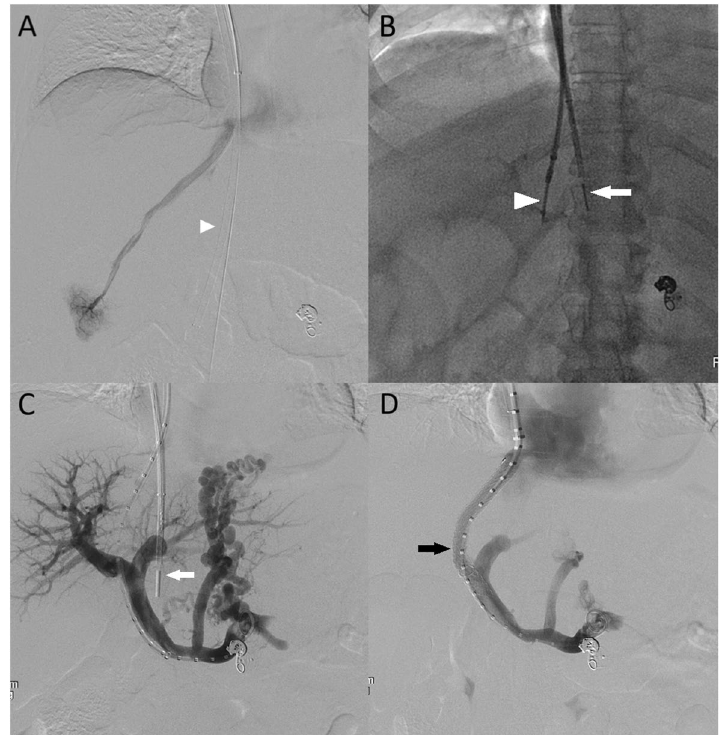
Fig. 2 A Sample Case of Splenoportogram and TIPS placement. A. Right hepatic vein venogram with Blakemore tube noted in the background (white arrowhead). B. ICE catheter (white arrow) positioned at the level of the main portal vein. Advancement of the needle (white arrowhead) through hepatic vein towards main portal vein. C. Portovenogram through marked pigtail showing hepatopetal flow with multiple esophageal varices. The ICE catheter is positioned at the level of the right main portal vein (white arrow). D. Portovenogram demonstrating successful TIPS stent placement (black arrow) and significant reduction in opacification of the esophageal